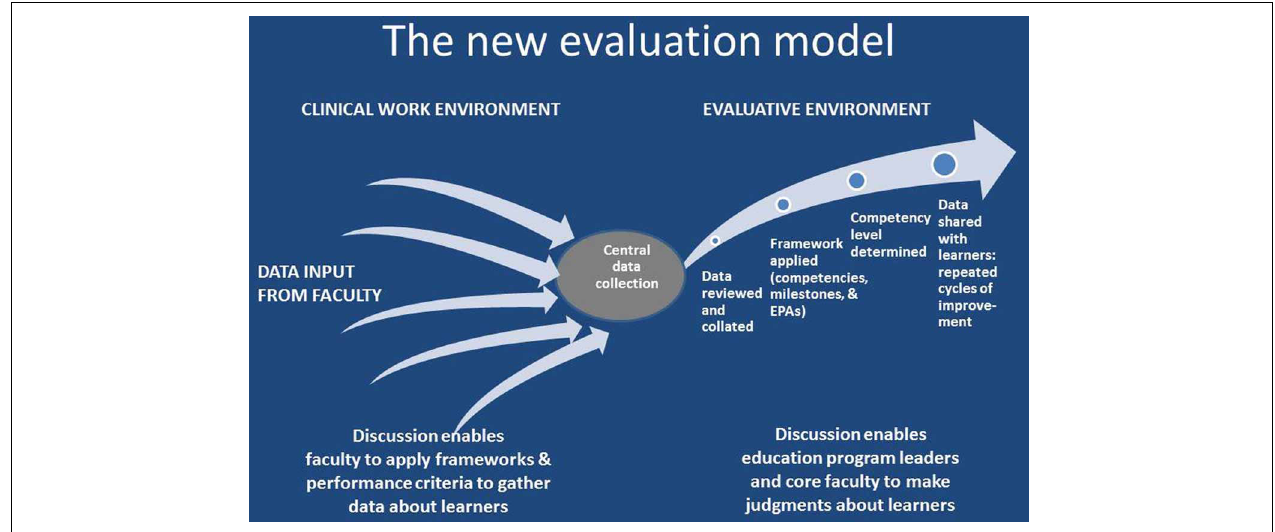
FIGURE 1 | Sample evaluation model using narrative